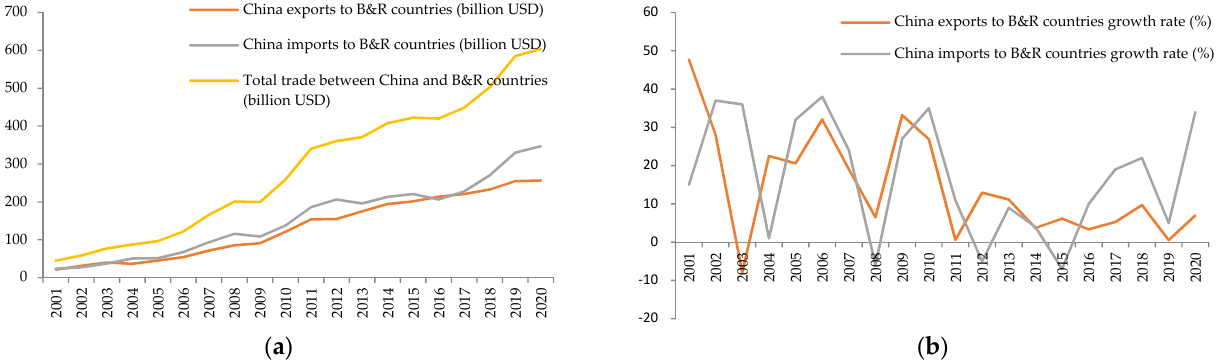
Figure 1. ( a ) Evolution of trade volume between China and B&R countries; ( b ) evolution of trade growth rate between China and B&R countries. Data Source: UN COMTRADE database.